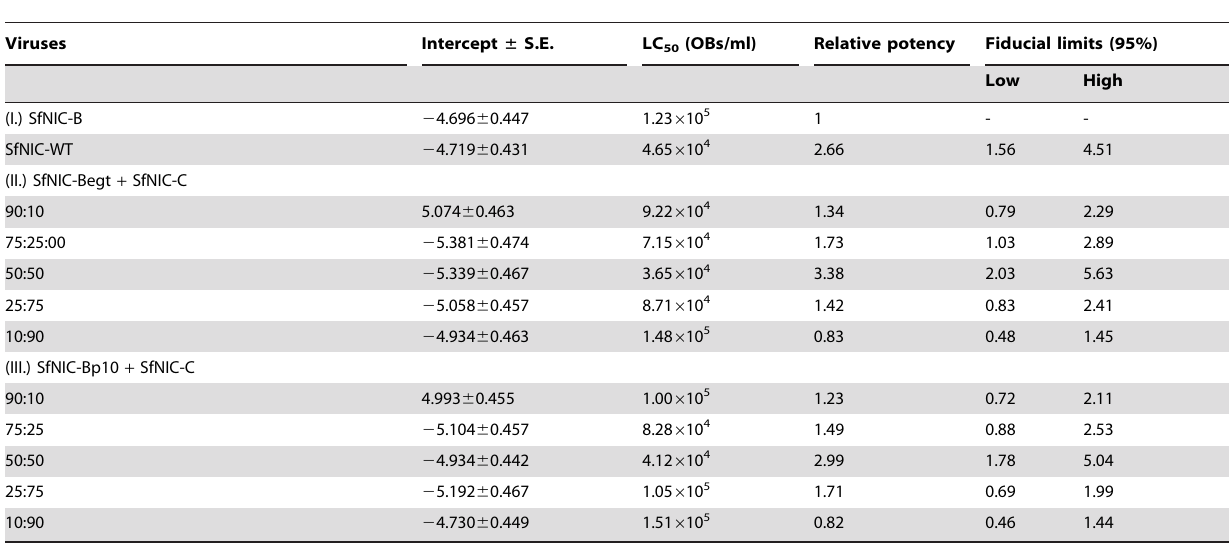
Table 3. Probit regression analysis of virus induced mortality in Spodoptera frugiperda second instars inoculated with (I.) Wild-type SfMNPV (SfNIC-WT) and purified variant SfNIC-B occlusion bodies (OBs). (II.) OBs comprising co-occluded mixtures of SfNIC-Begt and SfNIC-C defector genotype in the proportions indicated. (III.) OBs comprising co-occluded mixtures of SfNIC-Bp10 and SfNIC-C defector genotype in the proportions